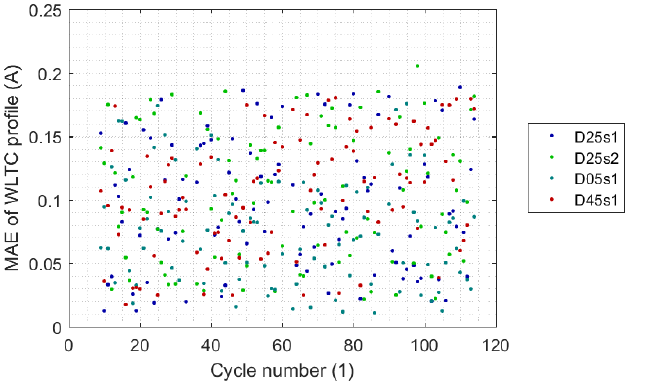
Figure 11. Mean absolute error of required and measured current profile during discharging for all the drive cycle discharging cycles for individual measured cells.